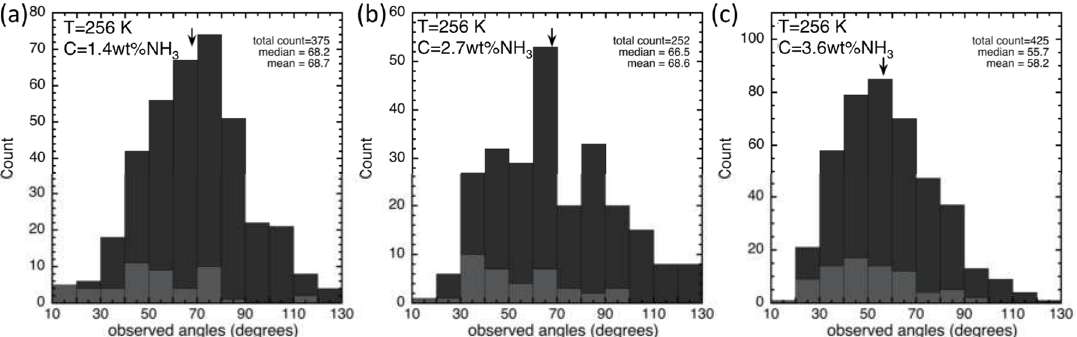
Figure 7. Histograms of dihedral angles measured in the H 2 O–NH 3 partial melt system. Samples with bulk composition of ( a ) 1 wt % NH 3 , ( b ) 2.7 wt % NH 3 , and ( c ) 3.6 wt % NH 3 (as determined by refractive index) were held at T = 256 K for 121–552 h and imaged in a cold room at the same temperature. Images were analyzed digitally (dark gray) and by hand (light gray) as provided individually in Table 2, whereas the arrow and results in the right upper corner of each distribution are for the combined total.